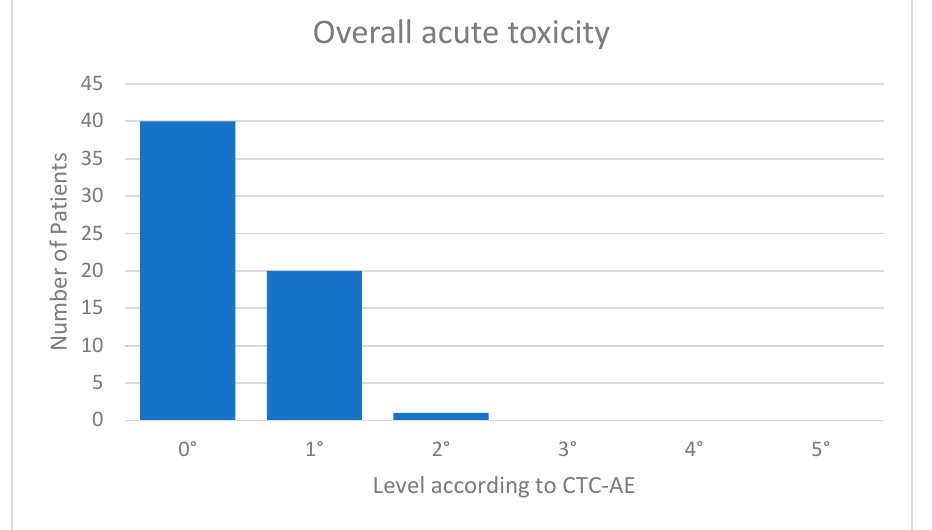
Figure 3. Acute toxicity.